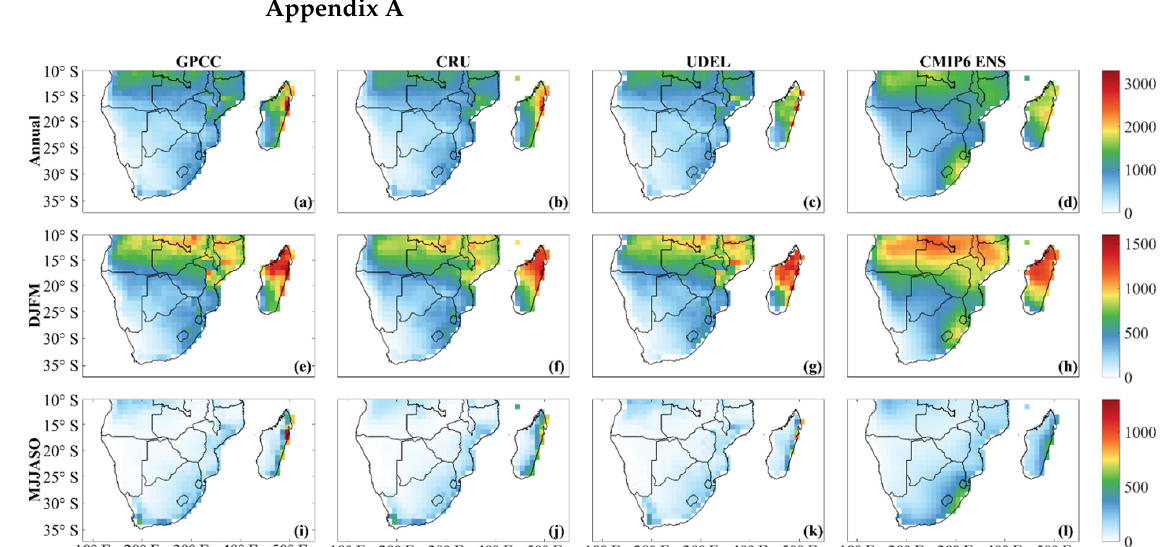
Figure A1. Spatial distribution of accumulated precipitation climatology (mm) over Southern Africa. ( a – d ) Annual; ( e – h ) DJFM; and ( i – l ) MJJASO precipitation from ( a , e , i ) GPCC; ( b , f , j ) CRU; ( c , g , k ) UDEL; and ( d , h , l ) CMIP6 ensemble mean.